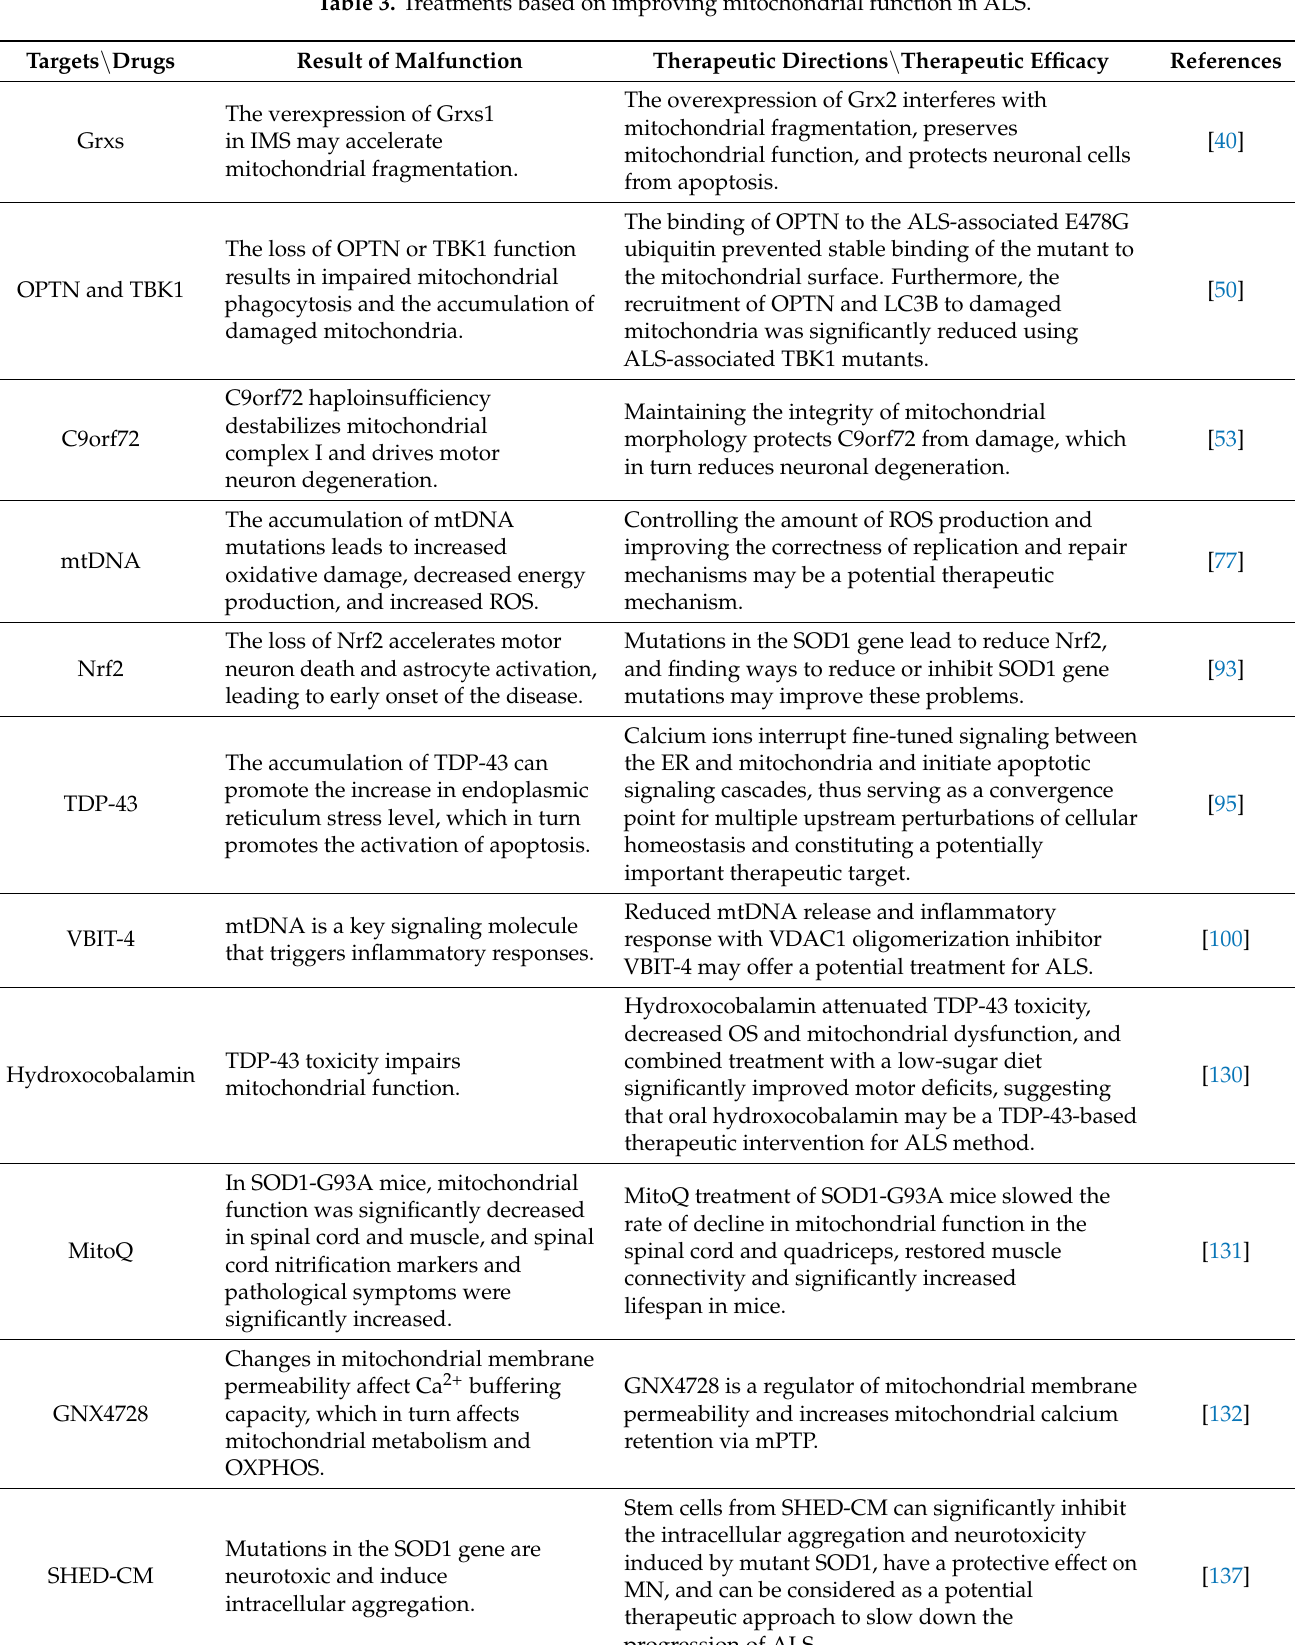
Table 3. Treatments based on improving mitochondrial function in